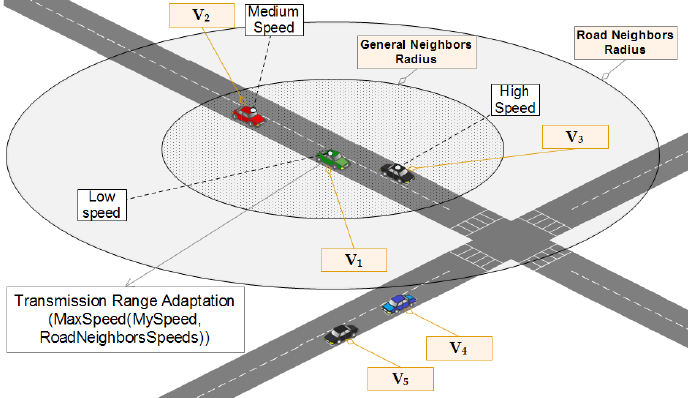
Figure 8. WHISPER behavior in the presence and influence of road neighbors on the transmission range